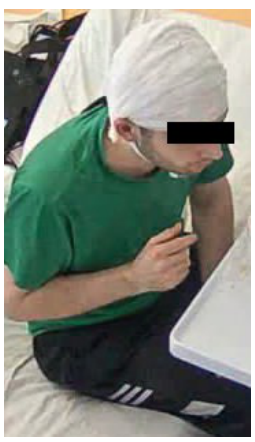
Figure 2. A frame from Video-EEG record. Seizure appears as freezing